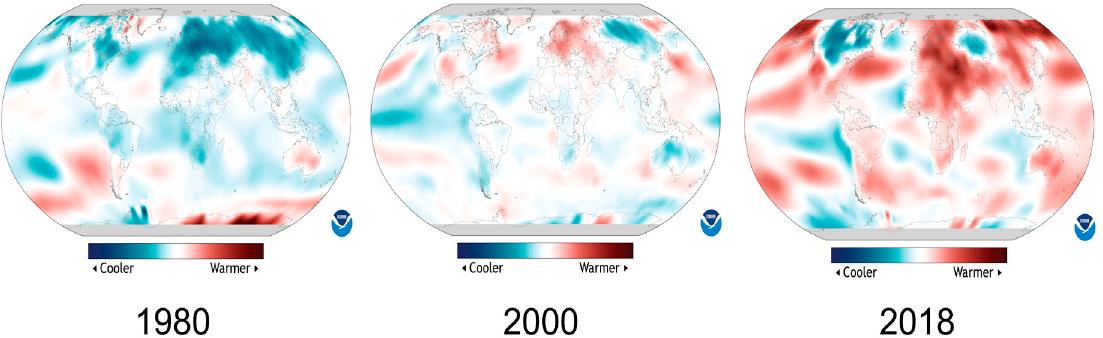
Figure 1. Temperature anomalies around the globe. Colors indicate places where average annual temperature was above or below based on the average temperature during 1981–2010. Data source: Climate.gov (accessed on 28 February 2022). Data provider: NOAA Environmental Visualization Laboratory